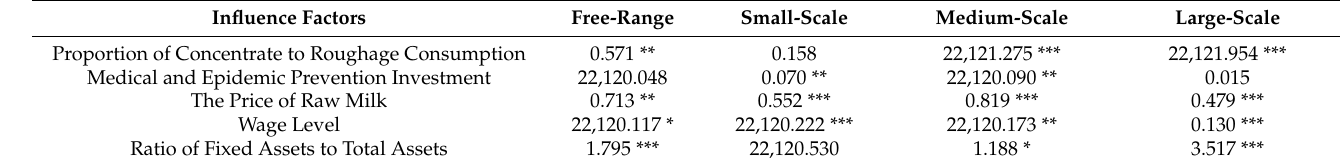
Table 10. Parameter estimation of technical inefficiency equation of four index input.